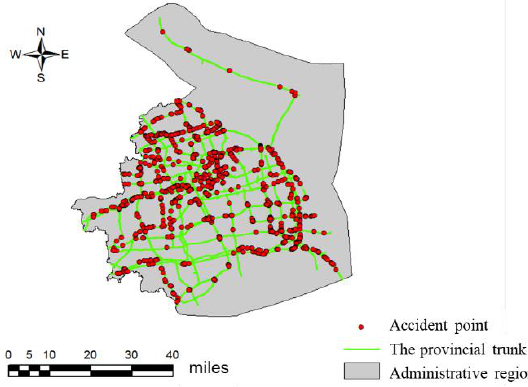
Figure 4. Distribution of Traffic Accidents in Shanghai (2017 – 2019).